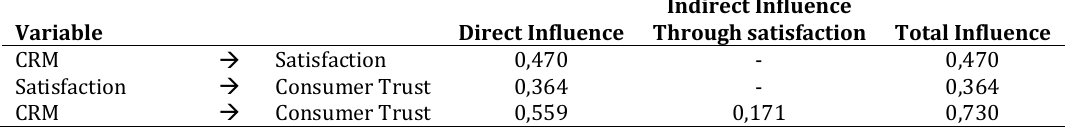
Table 2: Direct influence table, indirect influence and influence of total customer relationship marketing variables, customer satisfaction and trust